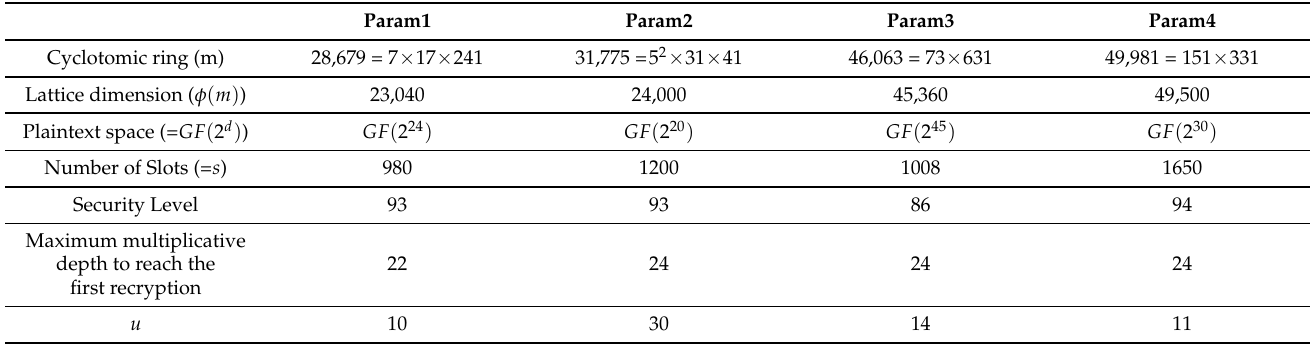
Figure 11. Multiplicative depth analysis. Table 5. Parameters for